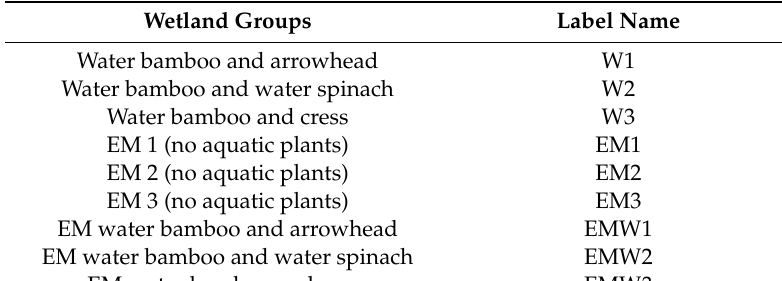
Table 1. Label name of each wetland group.